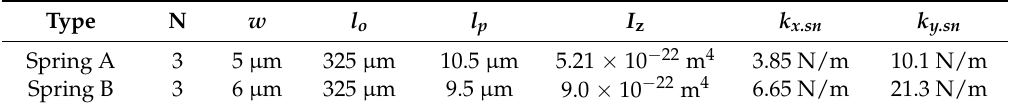
Table 2. Parameters for each type of serpentine spring.